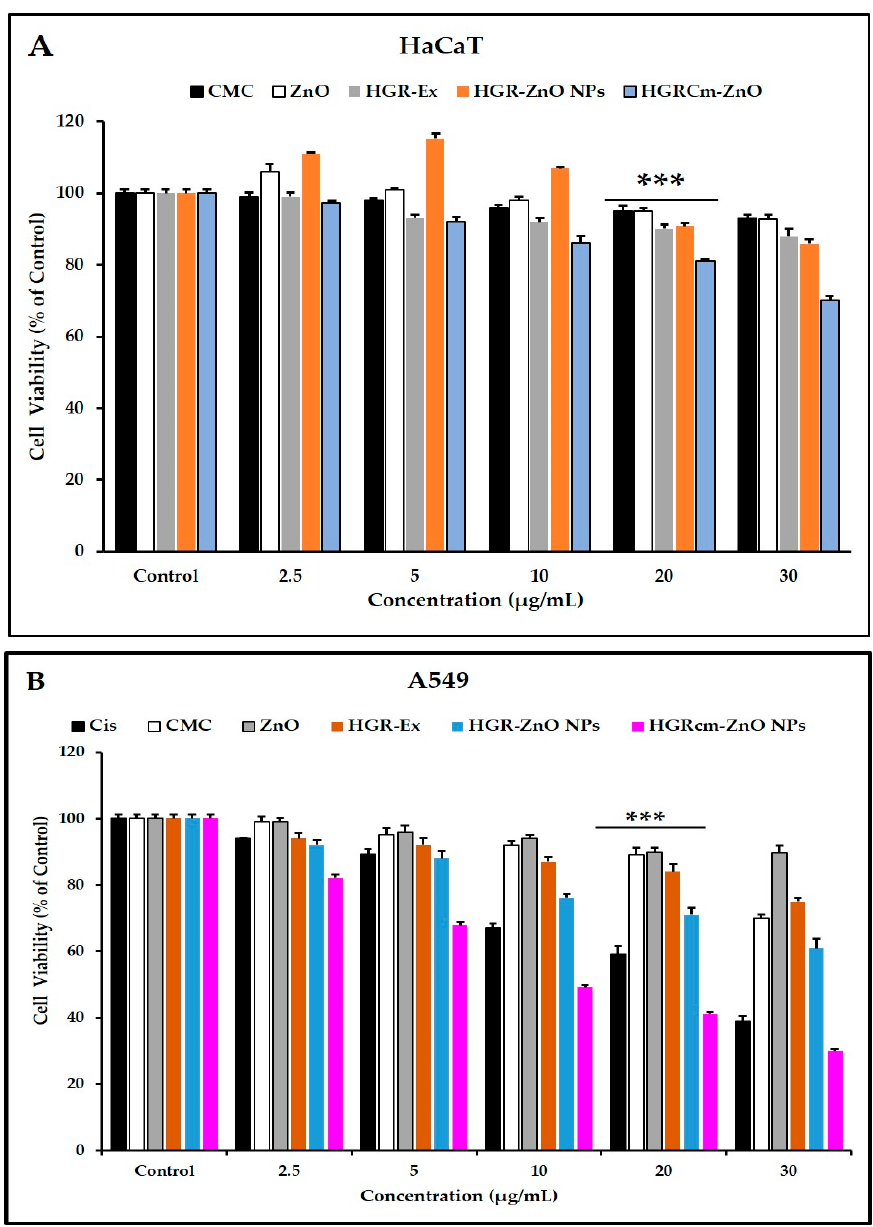
Figure 4. Cell viability of HGRCm-ZnO NPs, CMC, root extract, and cisplatin based on the MTT assay. ( A ) HaCaT cells; ( B ) A549 cells. Each bar represents the mean ± SE of duplicate samples from three independent experiments (*** p < 0.001 using Student’s t -test compared to the control.).